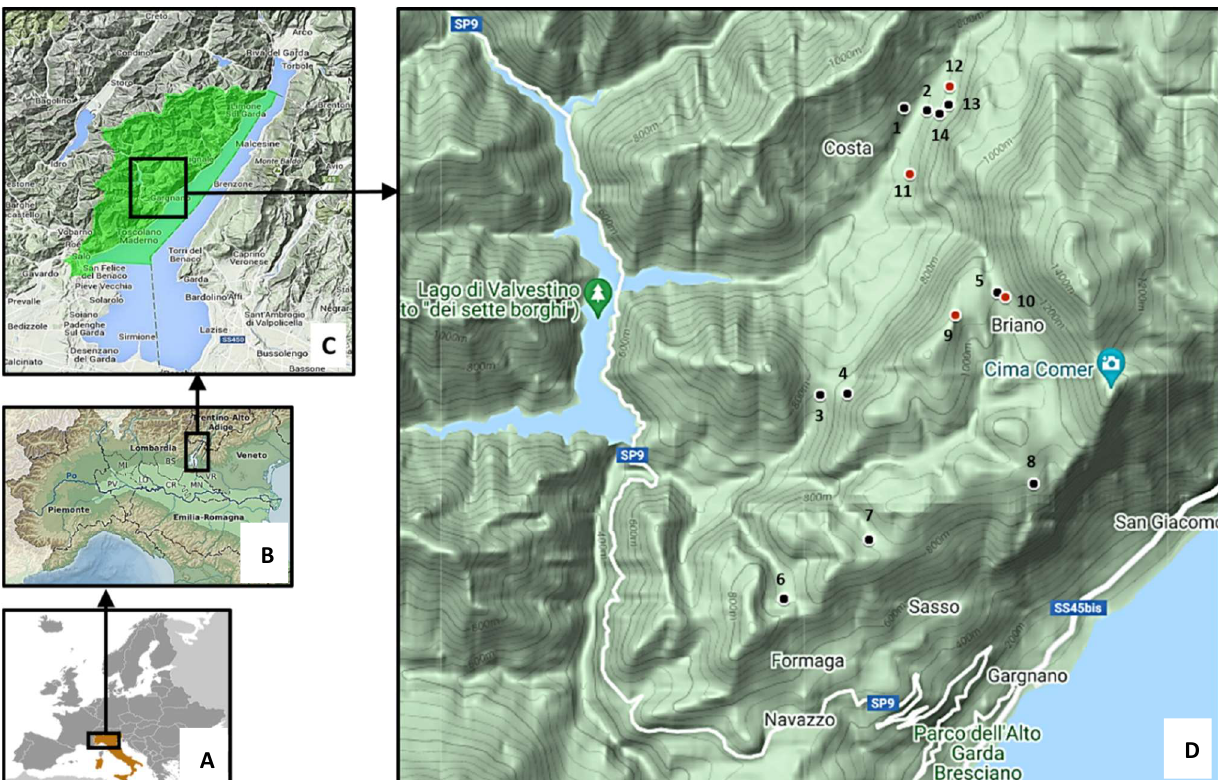
Figure 1. Map of the study area: ( A ) = Italy with the macro region area denoted; ( B ) = Lombardy region and Lake Garda area, BS represents Brescia Province; ( C ) = Alto Garda Bresciano Park area denoted in green; ( D ) = Gargnano area with study sites. Red circles indicate sites positive for M. microti (9 and 11 positive rodent samples; 10 and 12 positive environmental samples). 1 = Via Costa 1; 2 = Via Costa 2; 3 = Passo di Magno 1; 4 = Passo di Magno 2; 5 = Briano; 6 = Lama; 7 = Navone; 8 = Fa; 9 = Sembrune; 10 = Bocca Lovere; 11 = Bertu; 12 = Praa 1; 13 = Praa 2; 14 = Praa 3. Further details on the sites can be found in Table S1 (Supplementary